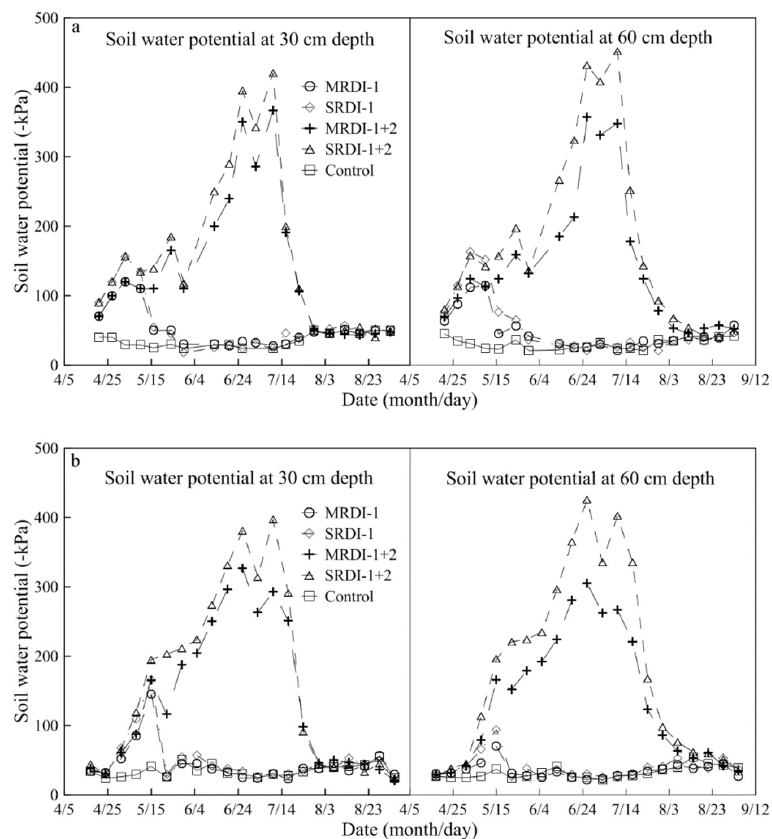
Figure 2. Soil water potential at 30 cm and 60 cm depth in irrigated zone in 2009 ( a ) and 2010 ( b ). MRDI-1 and SRDI-1 were applied with moderate and severe water stress, respectively, during Stage 1 (0–30 DAB), and fully irrigated during the other stages; MRDI-1+2 and SRDI-1+2 were applied with moderate and severe water stress, respectively, during Stage 1+2 (0–86 DAB), and fully irrigated during other stages.